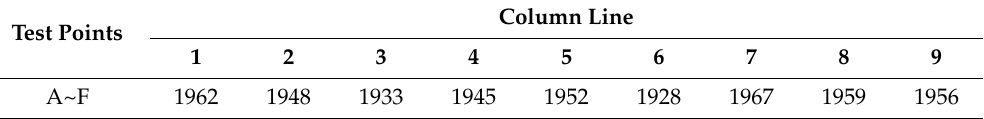
Table 5. R-wave velocities (m / s) at test grid points in S24D210 slab (unit: m / s).